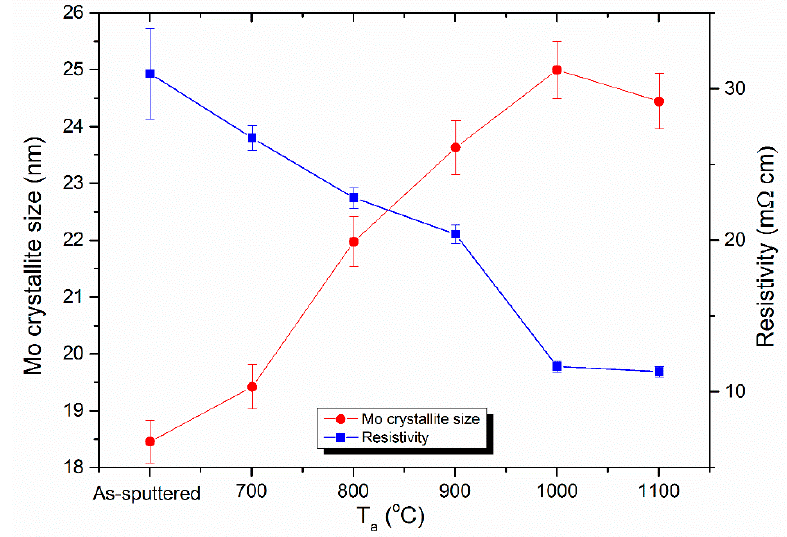
Figure 5. Evolution of Mo crystallite size and resistivity of Mo thin films, as a function of annealing temperature.